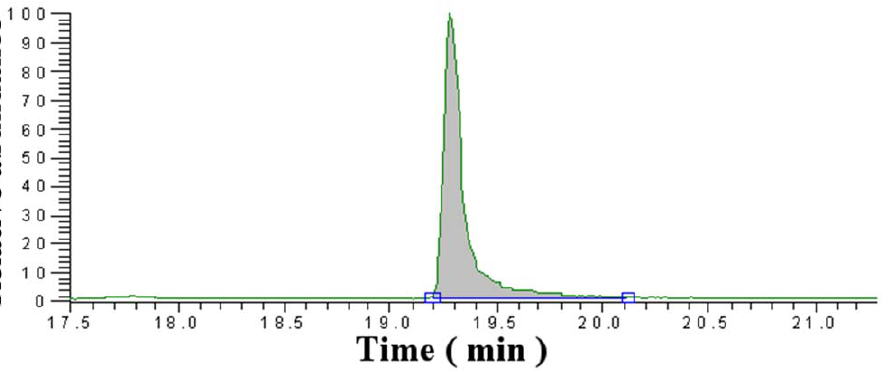
Figure 6. Liquid chromatography–mass spectrometry (LC-MS)/Single Ion Monitoring (SIM) chromatogram. Representative Profile for the Oleic Acid-Protein Complex and its 18 C 13 isotopic Oleic Acid Internal Standard (ISTD). The original Complex was diluted 60 times with ISTD at 0.5 m g/mL. 25 m L sample solution was injected on to the column.